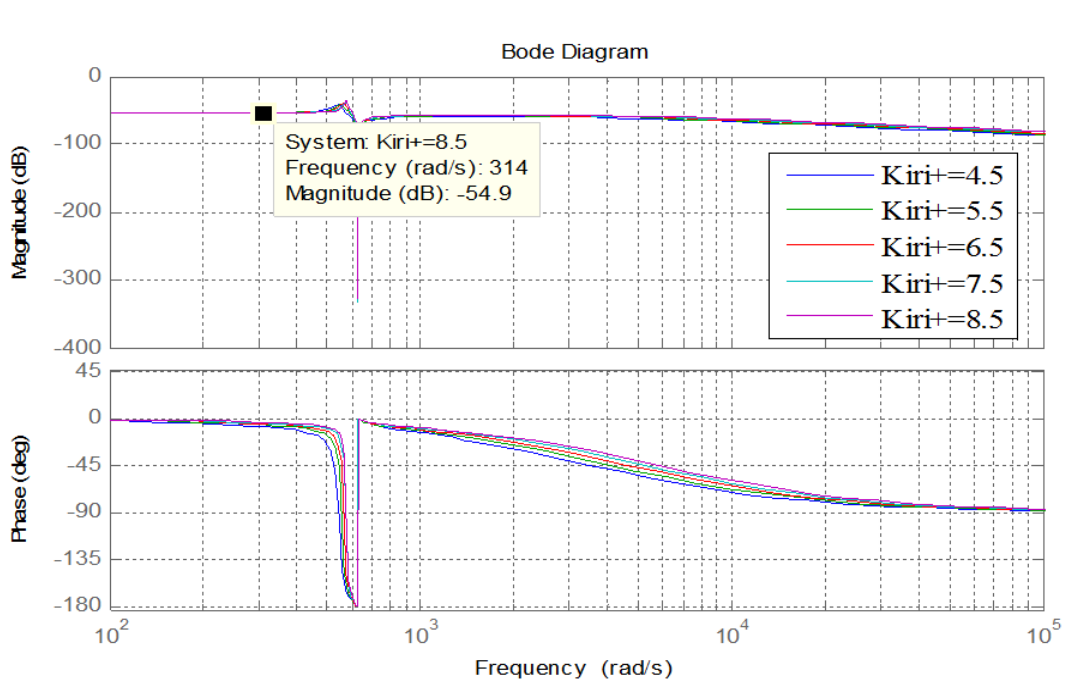
Figure 4. Bode diagram of the inner current closed-loop transfer function to the disturbance component (such as + sd p   ) during the fault transient